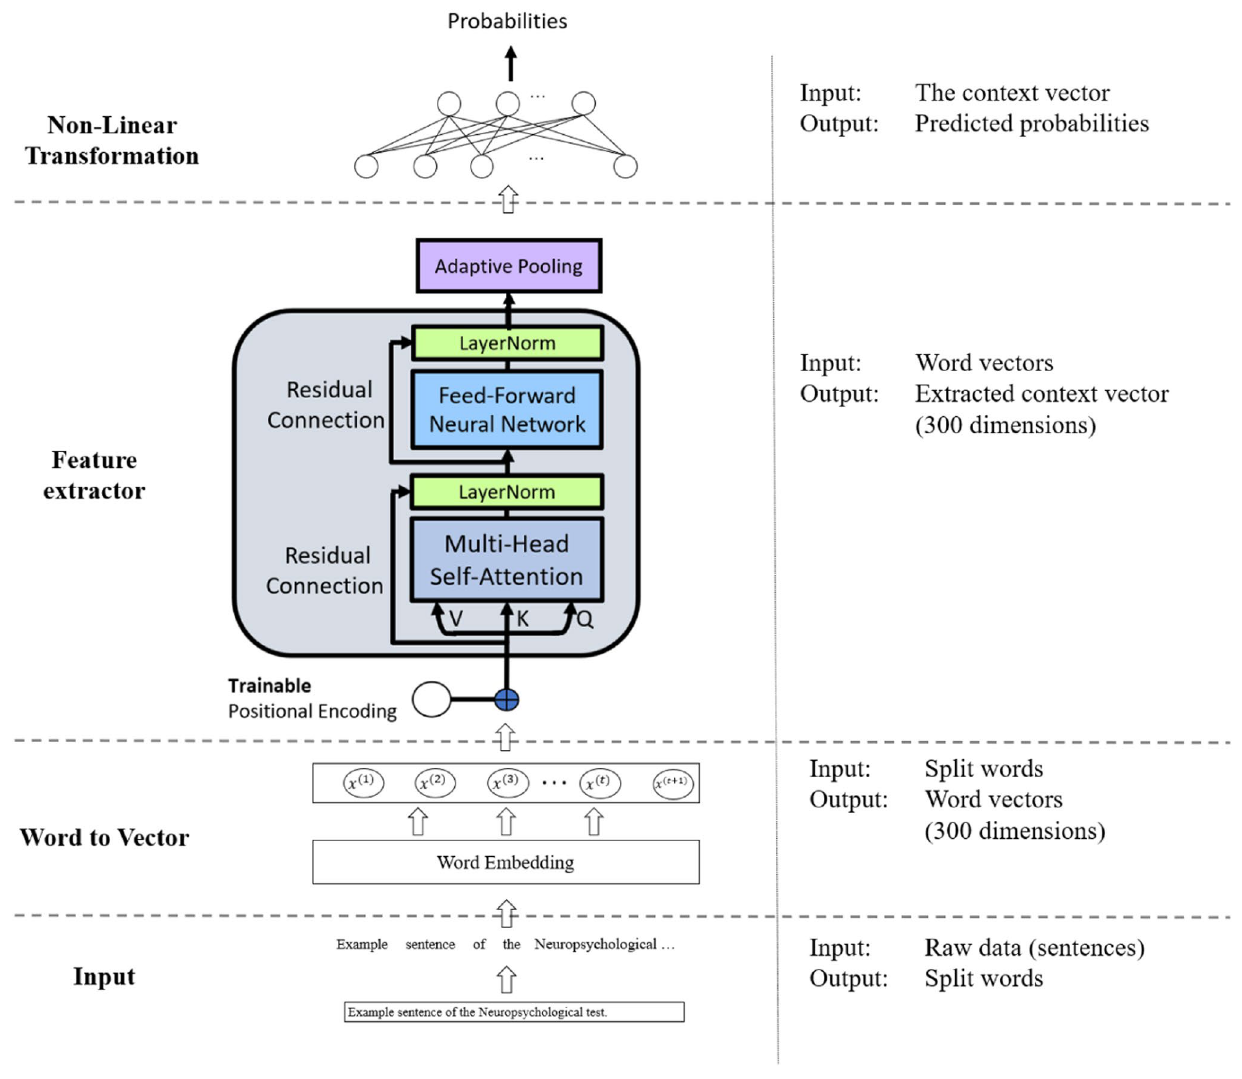
Figure 3. Screening engine using a single neuropsychological